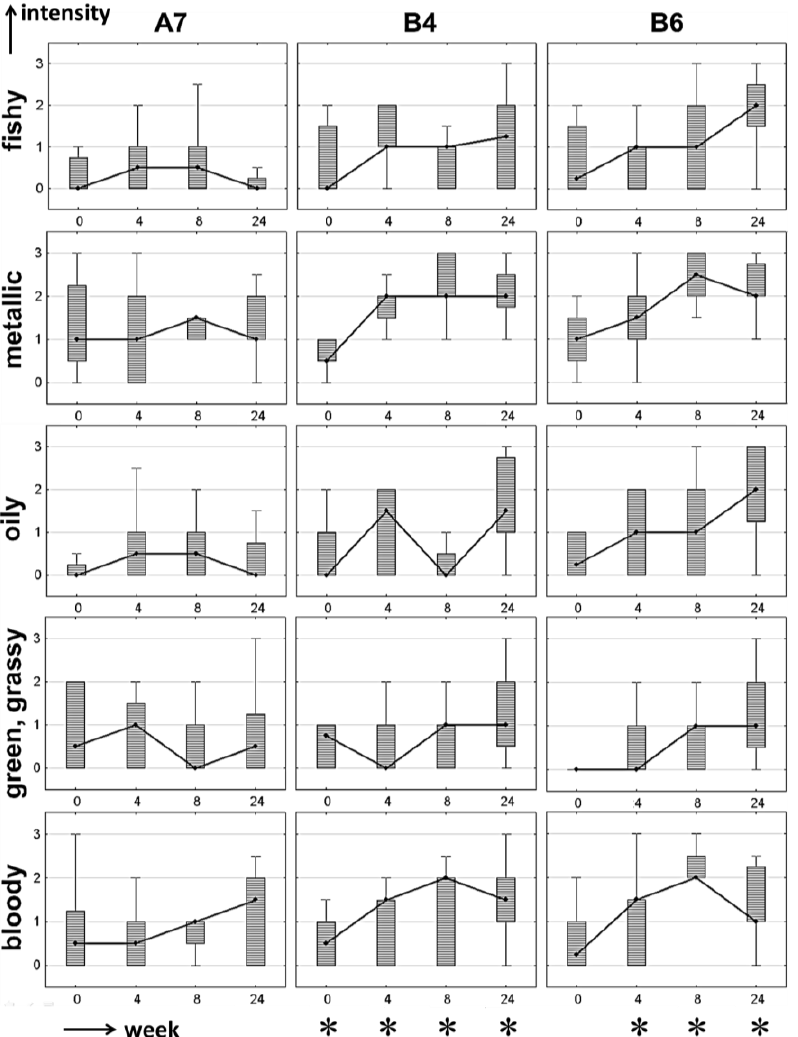
Figure 4. Box-plots of sensory evaluation of a stable formulation (A7) and two less stable formulations (B4, B6) over storage period (weeks). Median : • ; whiskers : ±minimum-maximum ratings (without outliers); box : percentiles 25%–75%. * off-flavor (perceived by more than 2/3 of the